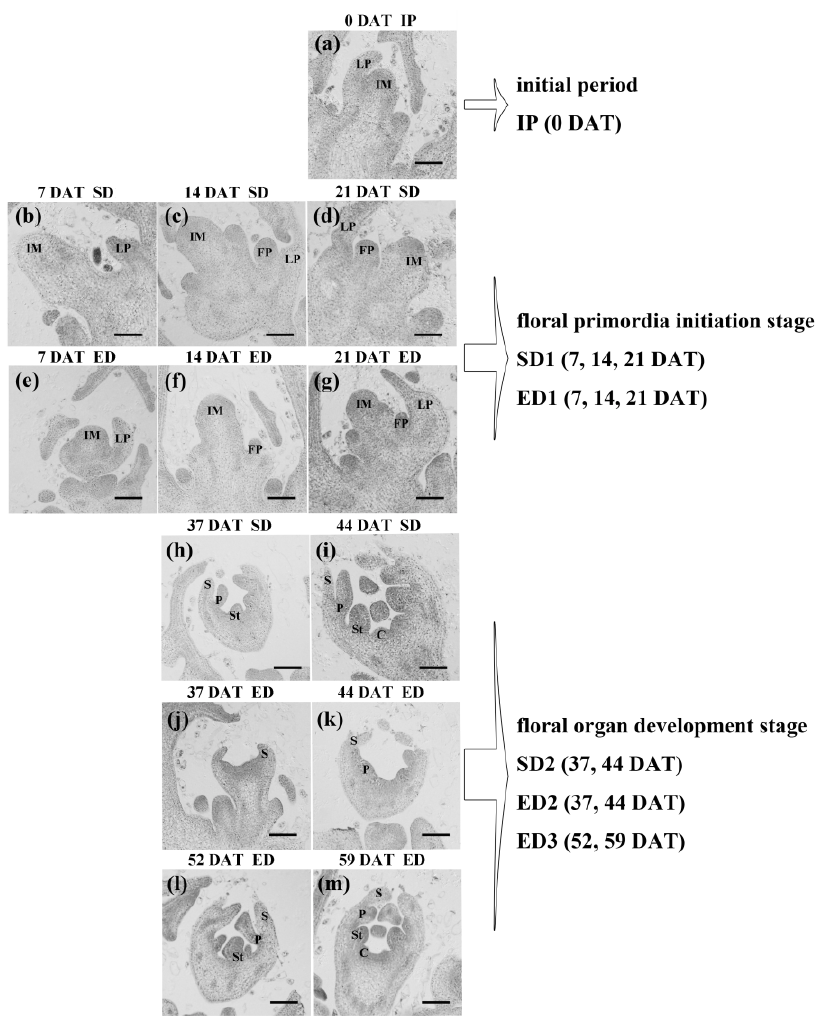
Figure 1. Before the first flower opens, the morphological characterizations of shoot apical meristem (SAM, 0 DAT, 7 DAT, 14 DAT, 21 DAT) and later flower bud (37 DAT, 44 DAT, 52 DAT and 59 DAT) corresponding to the time points of RNA-Seq. ( a ) The SAM before photoperiod treatments, namely initial period (IP). ( b – d , h , i ) The SAM and flower buds under short-day (SD, 8 h/16 h) light cycle. ( e – g , j – m ) The SAM and flower bud under equal-day (ED, 12 h/12 h) condition. DAT, days after photoperiod treatment; IM, inflorescence meristem; FP, floral primordia; LP, leaf primordia; S, sepal; P, petal; St, stamen; C, carpel. Bars = 100 μ m.